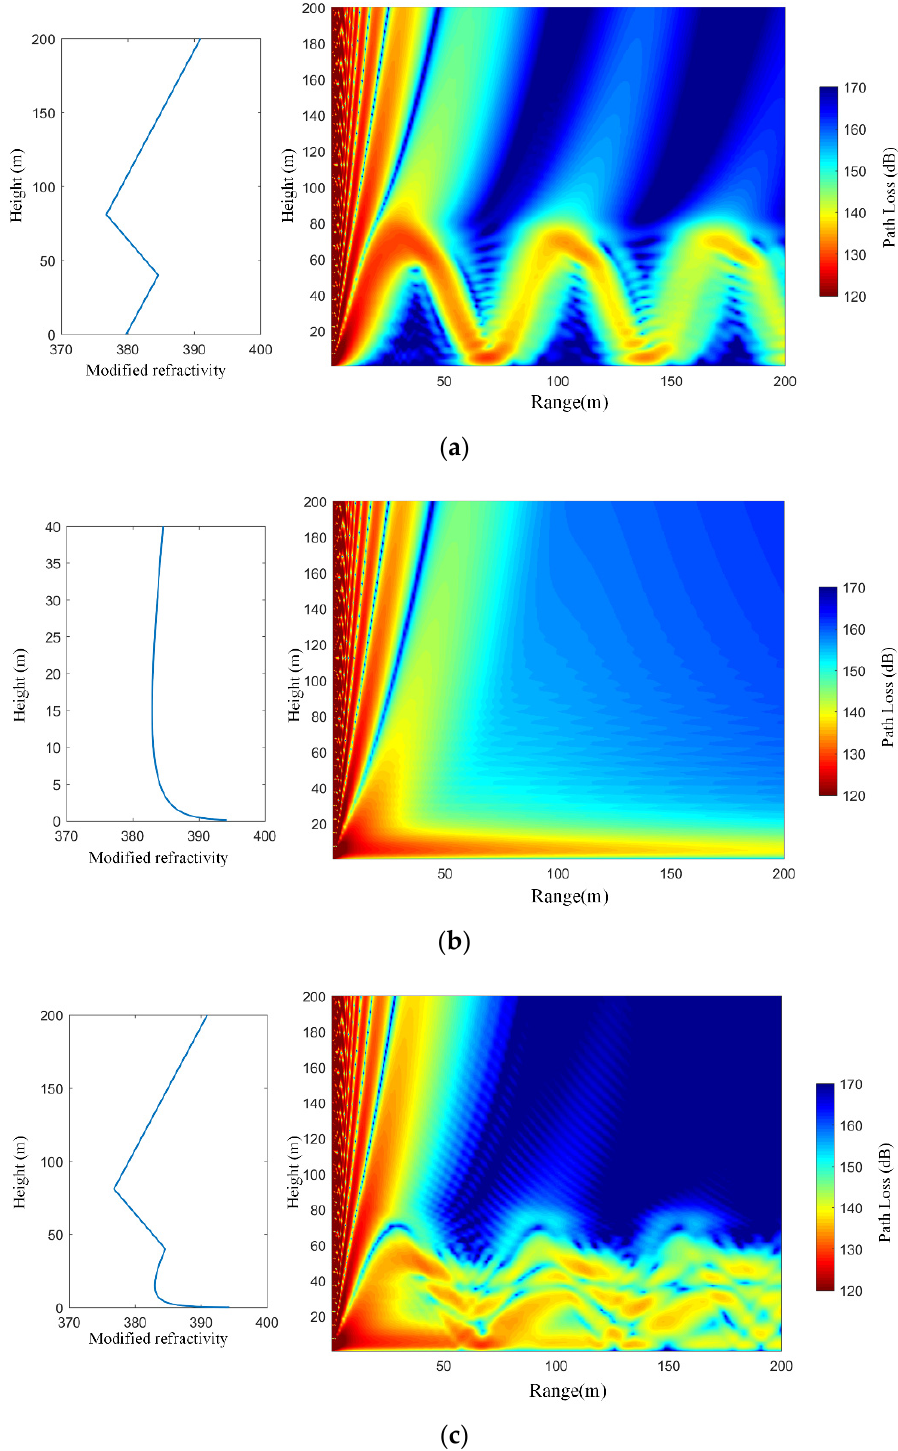
Figure 10. Modi fi ed refractivity pro fi les and path loss distributions in three cases: ( a ) surface duct; Figure 10. Modified refractivity profiles and path loss distributions in three cases: ( a ) surface duct; ( b ) evaporation duct; and ( c ) hybrid duct. ( b ) evaporation duct; and ( c ) hybrid